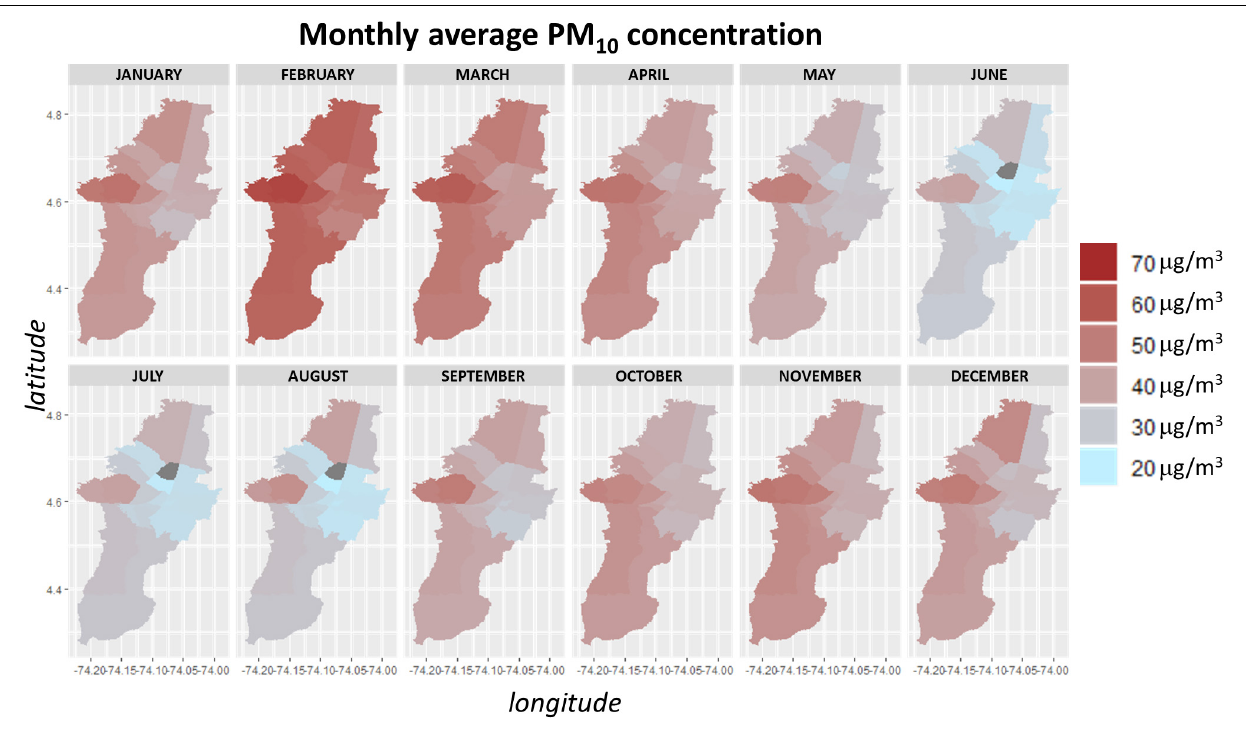
FIGURE 13 | Spatial distribution of the average concentration of PM10 in